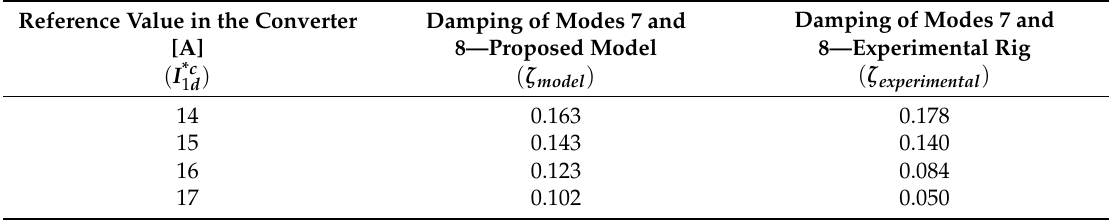
Table 10. Comparison between the damping of modes 7 and 8 given by the proposed model and the those found in the experimental system, for SCR = 2.1652 and PLL bandwidth equal to 51.514